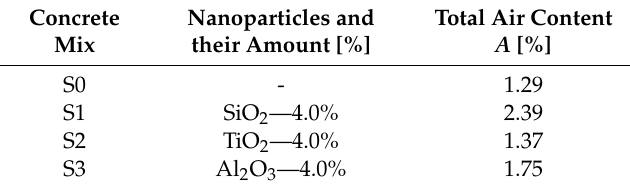
Table 4. Physical properties of self-compacting concrete mixes (based on [22]).